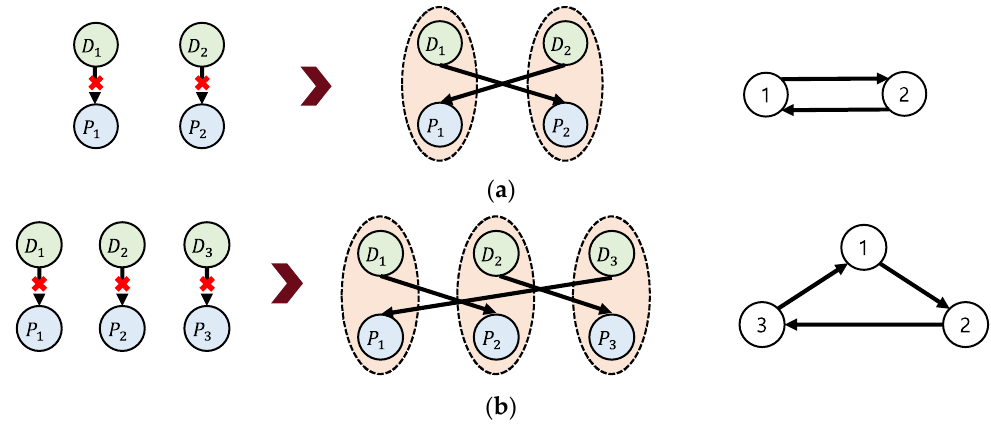
Figure 1. Illustration of ( a ) two-pair and ( b ) three-pair kidney exchanges.